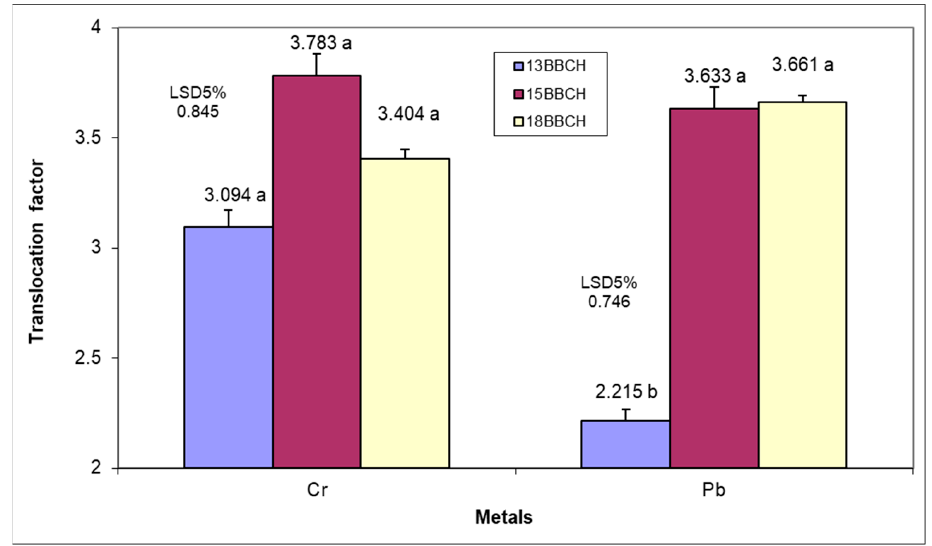
Figure 2. TF of Cr and Pb in different development stages of S. perfoliatum plants grown in heavy metal Ps. Error bars represents SE. Different letters (a, b) indicate significant differences ( p < 0.05) between stages .